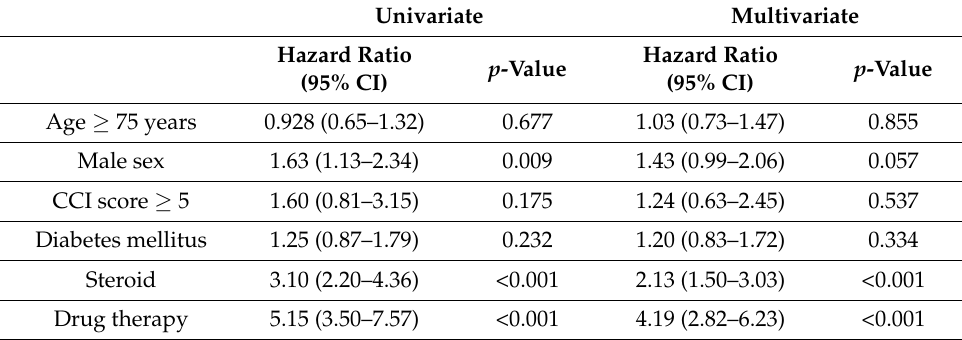
Table 3. Risk factors of invasive fungal